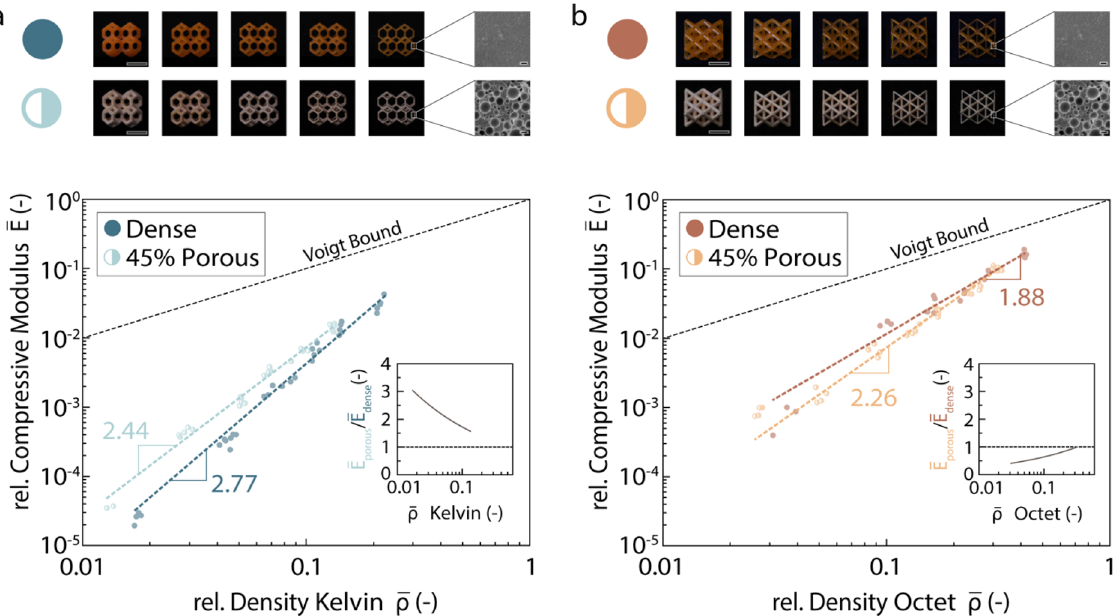
Figure 3. Mechanical properties of Kelvin and octet hierarchical lattices with varying relative densities. ( a , b ) Relative compressive modulus ( E ) of ( a ) Kelvin and ( b ) octet lattices with struts that are either dense or 45% porous. In these samples the relative density is changed by varying the strut thickness. The insets show the ratio between the relative compressive modulus for microporous and dense Kelvin lattices ( E porous / E dense ) at varying relative densities of the overall structure ( ρ ). Scale bars: 5 mm in macroscopic images of lattices (Kelvin and octet); 10 µm in SEM close-ups of dried